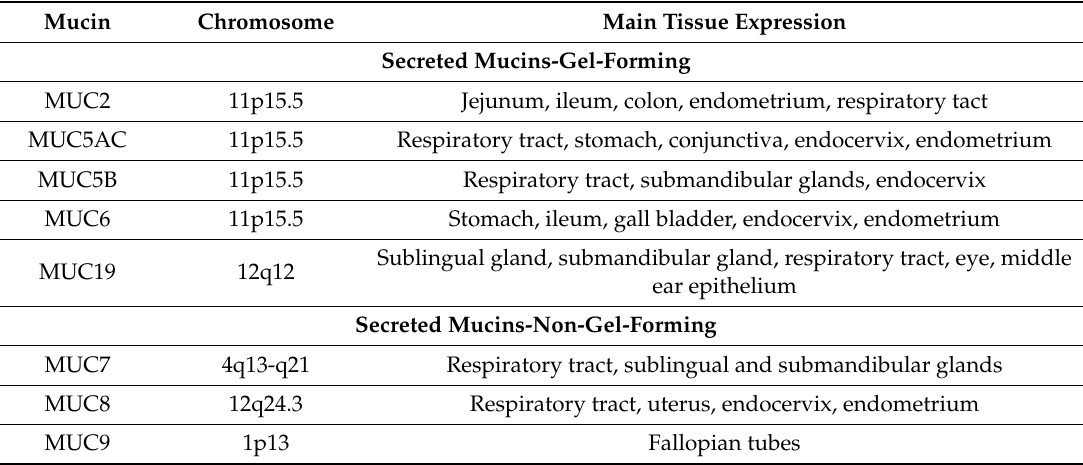
Table 2. Classification, chromosome localization and main tissue expression of human mucins [39,40]. Mucin Chromosome Main Tissue